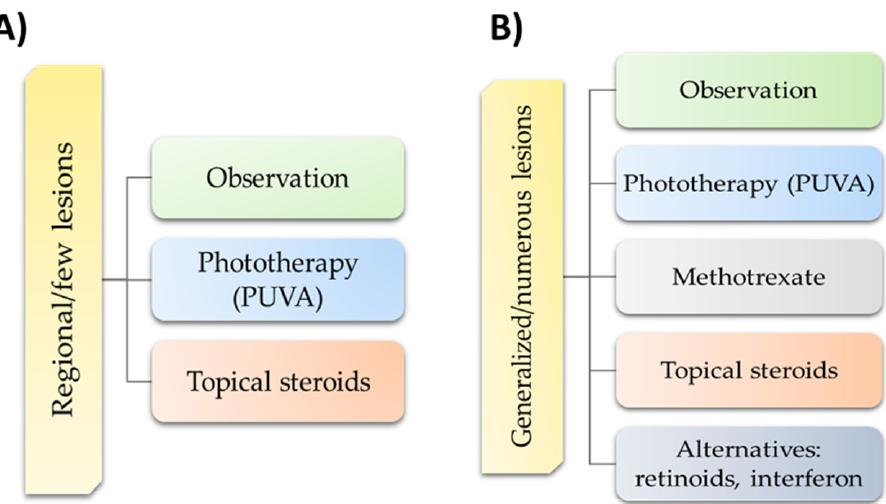
Figure 4. Management of regional lymphomatoid papulosis according to EORTC, ISCL, and USCLC consensus recommendations. ( A ) Management of regional lymphomatoid papulosis with few lesions according to EORTC, ISCL, and USCLC consensus recommendations; ( B ) management of generalized lymphomatoid papulosis with numerous lesions according to EORTC, ISCL, and USCLC consensus recommendations. Abbreviations: EORTC—European Organisation for Research and Treatment of Cancer; ISCL—International Society for Cutaneous Lymphomas; USCLC—United States Cutaneous Lymphoma Consortium; PUVA—Psoralen Ultra-Violet